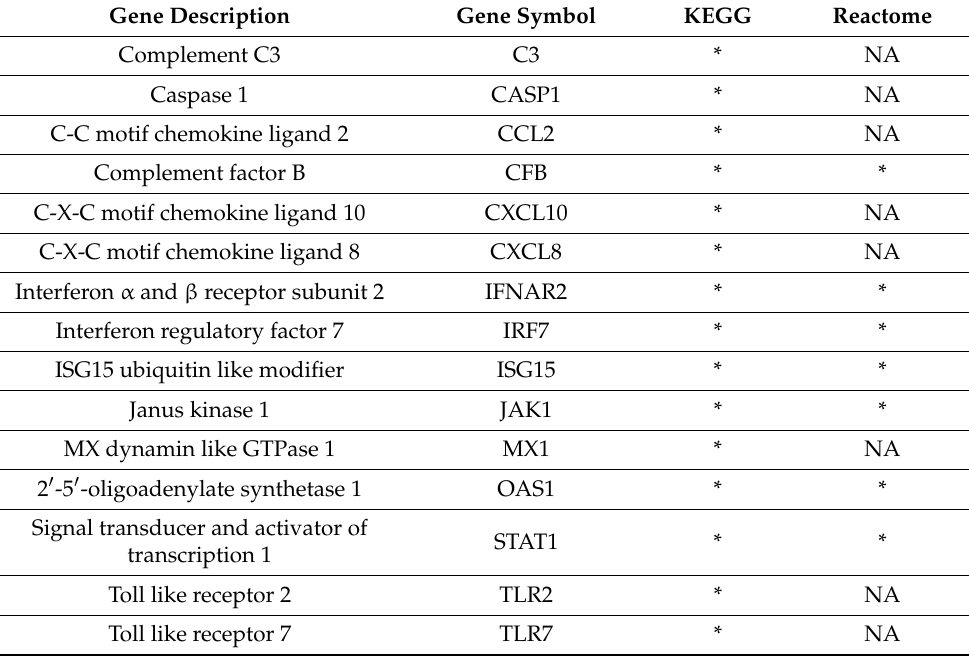
Table 1. Top 15 DEGs overlapped among DKD and COVID-19